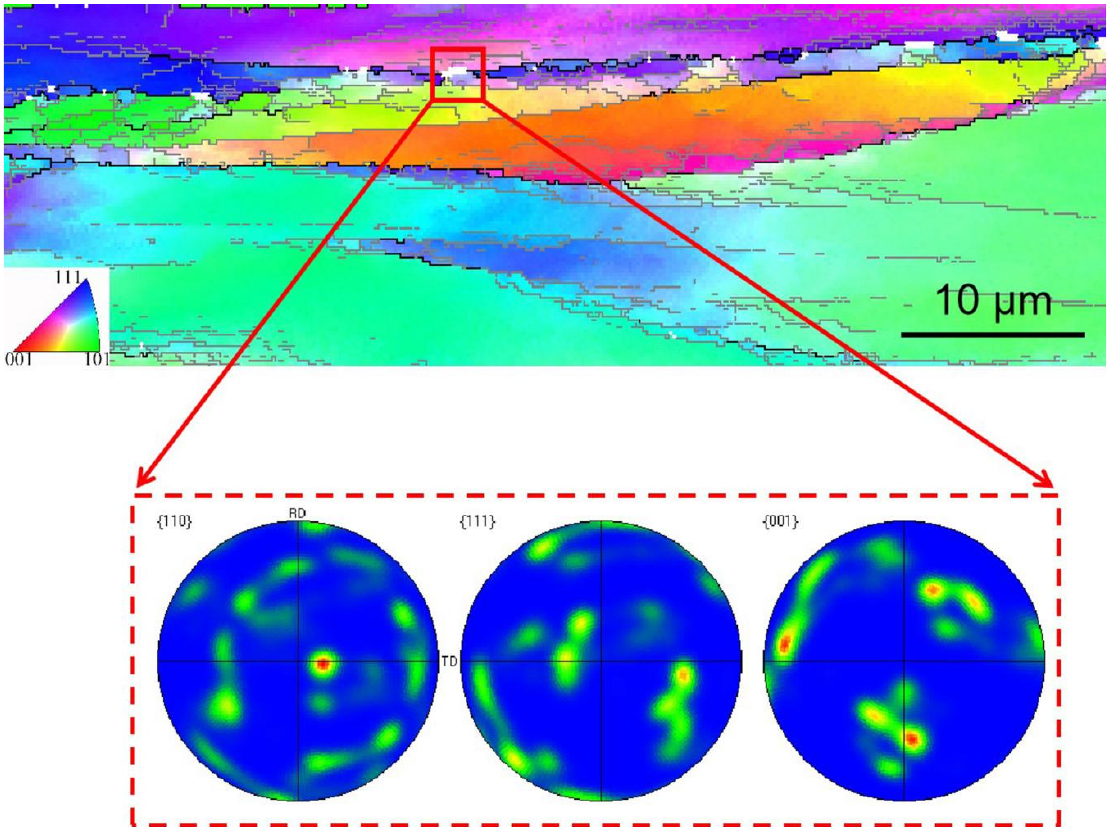
Figure 9. Pole figures (PFs) of a given local zone obtained from EBSD imaging at a true strain of 0.8 in the Ti-B12 alloy.